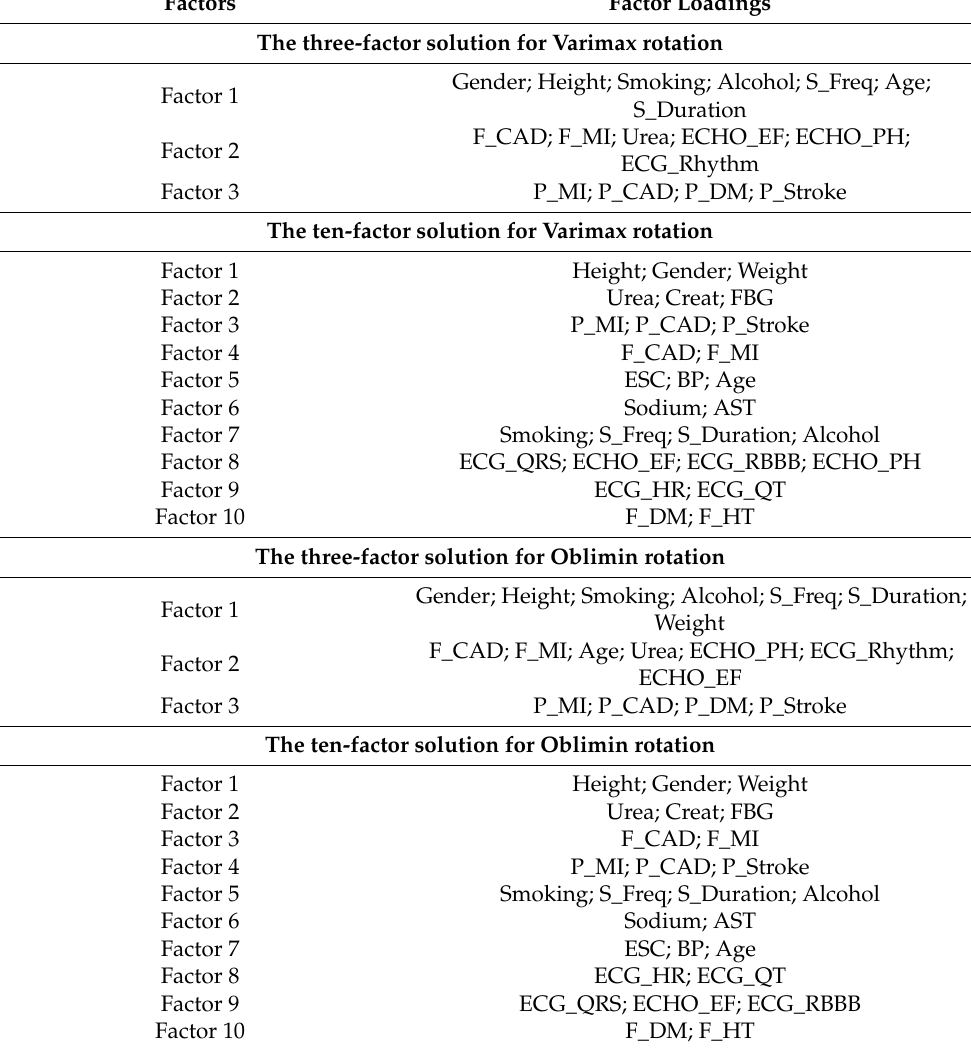
Table 3. An overview of the most important FA results for Varimax and Oblimin rotations. Factors Factor Loadings The three-factor solution for Varimax